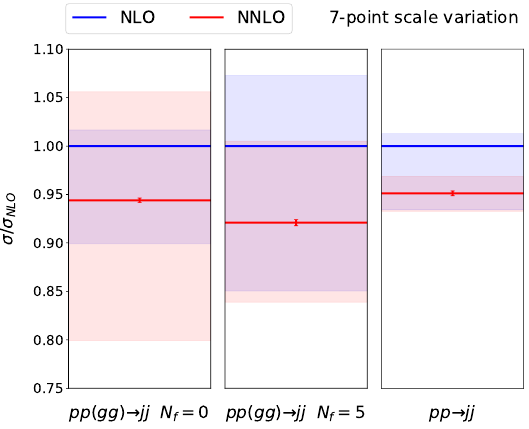
Figure 10 . Total cross section for pp ( gg ) → jj with N f = 0 (left), pp ( gg ) → jj with N f = 5 (centre) and pp → jj (right). Each result is normalized with respect to the corresponding NLO total cross section.